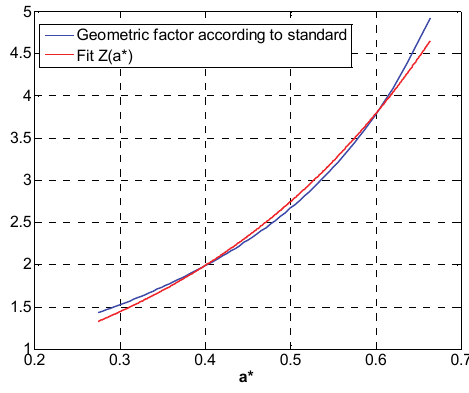
Figure 9: Fitting of function Z(a*).